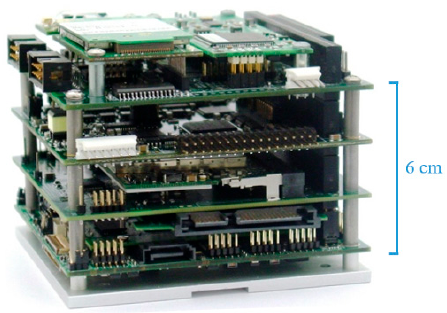
/ 104 stack (Credit: Diamond Figure 9. PC/104 stack (Credit: Diamond Systems). Figure 9. PC